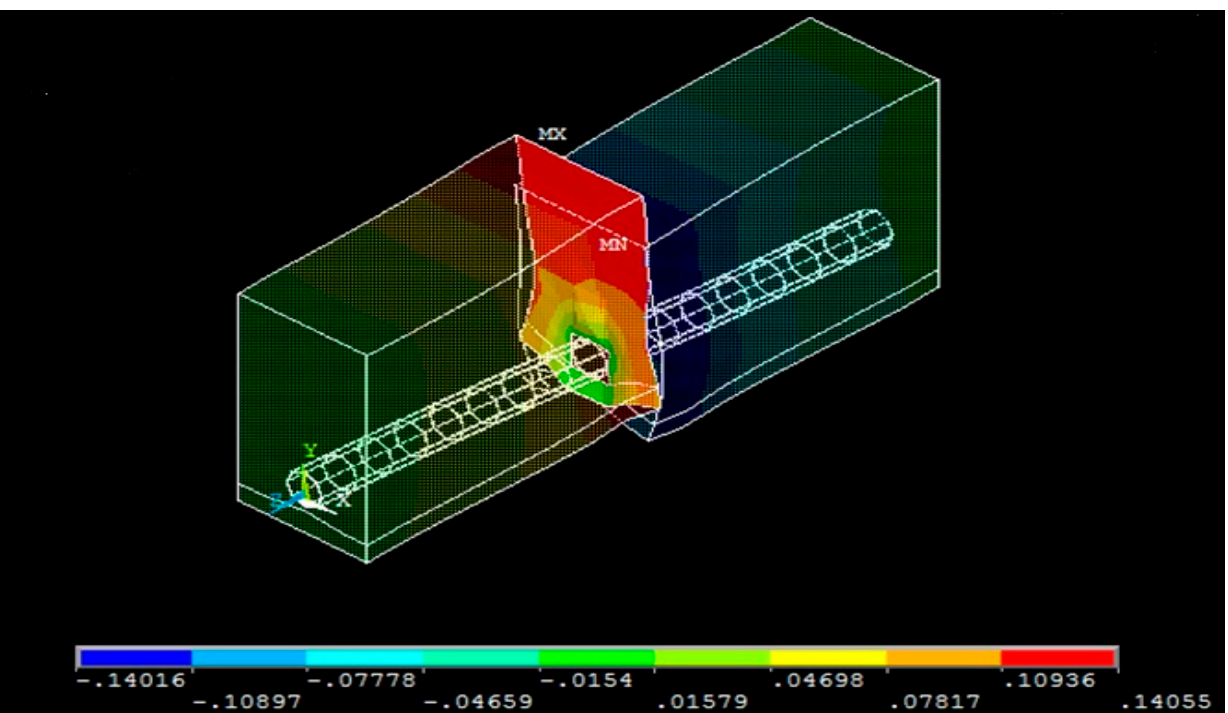
Figure 17. The typical vertical displacement of the GPC pipe.